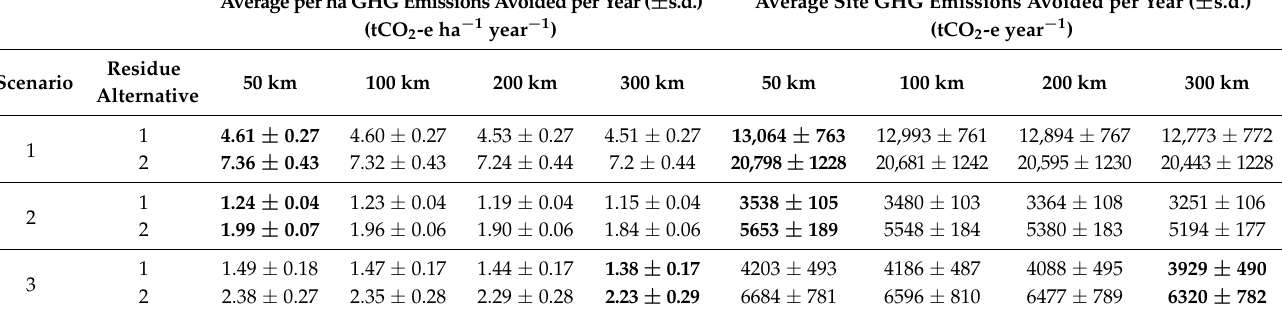
Table 5. Sensitivity analysis for the impact of transport distances on GHG emission offsets for each scenario for residue utilization alternatives 1 and 2 (average and standard deviation for a per hectare and site basis). AverageperhaGHGEmissionsAvoidedperYear( ±